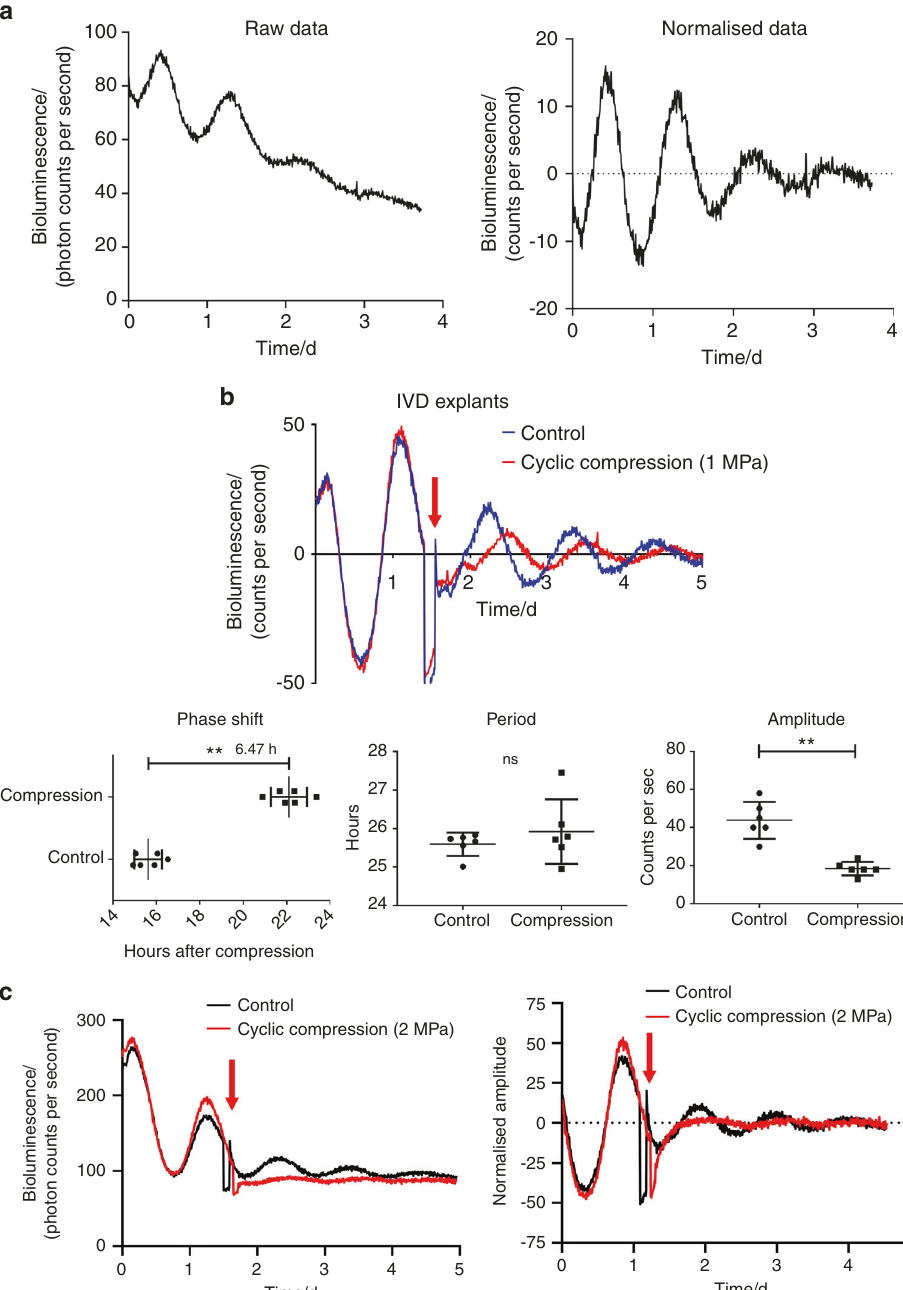
Fig. 2 Excessive mechanical loading dampens the circadian rhythm of IVDs. a Representative PER2::Luc bioluminescence trace of human primary NP cells transduced with lentiviral Per2 ::Luc. n = 6. b Representative PER2::Luc bioluminescence trace of mouse IVD explant culture with cyclic compression (1.0 MPa, 1.0 Hz, 2 h) and quanti fi cation of phase, period and amplitude. The red arrow at Day 1.5 indicates the time of mechanical loading. n = 6. c Representative PER2::Luc bioluminescence trace of mouse IVD explant culture with cyclic compression (2.0 MPa, 1.0 Hz, 1 h). The red arrow at Day 1.5 indicates the time of mechanical loading. n = 6. ns not signi fi cant, ** P <